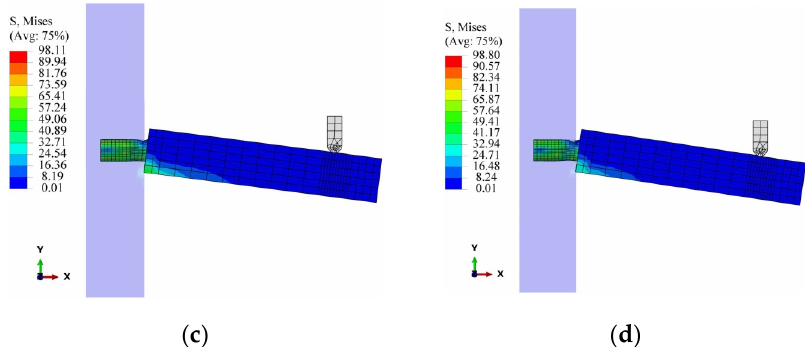
Figure 4. Stress distributions of the M–T joint T-shaped sample at different loading stages corresponding to the four points shown in Figure 3; ( a ) 364 N in linear stage, ( b ) the maximum load 778 N, ( c ) 594 N at failure stage, and ( d ) 366 N at failure stage. (unit MPa).